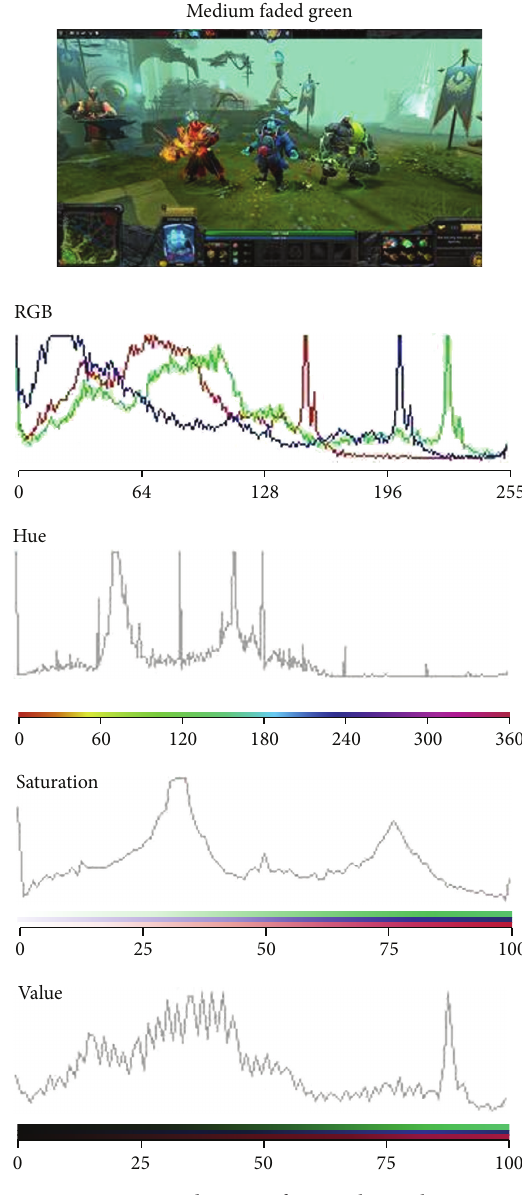
Figure 2: Video game frame color